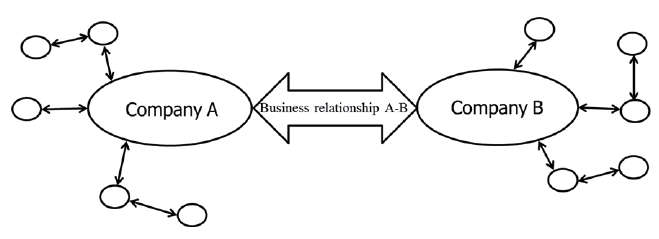
Fig. 1 – Connection of business relationships: complex questions. Source: (Håkansson et al., 2009), p.